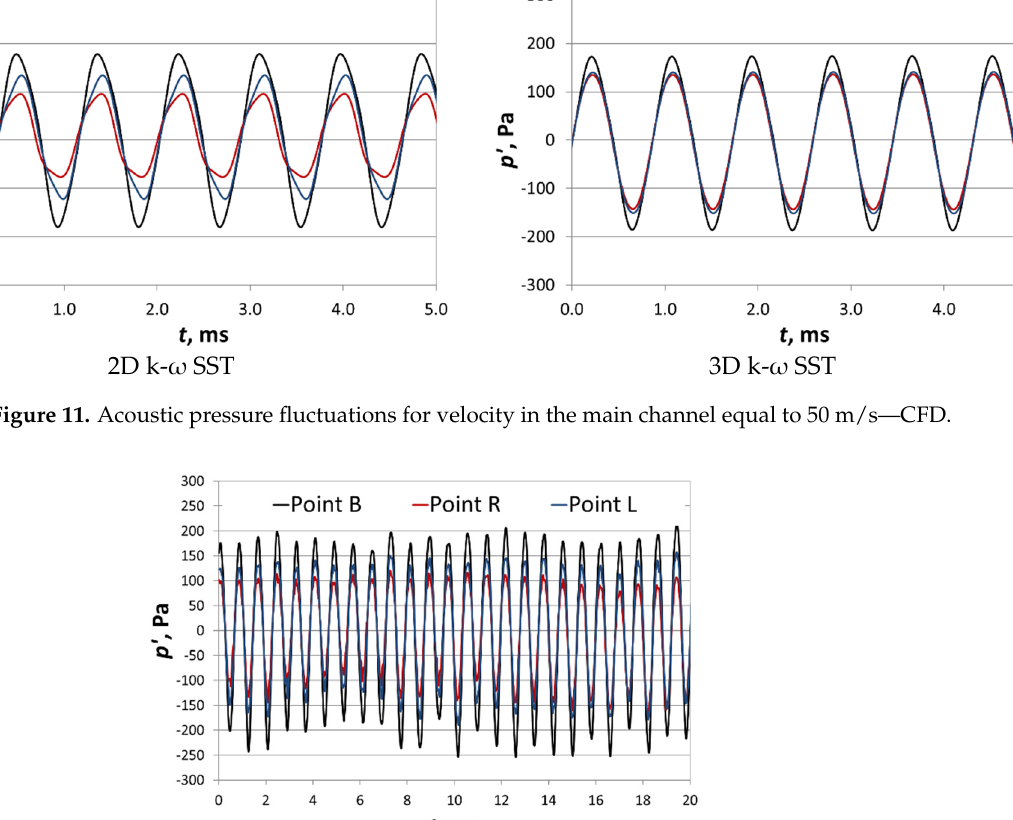
Figure 10. Spectral analysis of SPL for velocity in the channel equal to 40 m/s—experimental data.